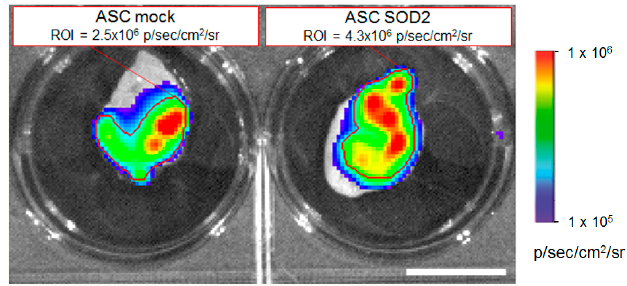
Figure 5. SOD2 -expressing ASCs show improved engraftment potential: ex vivo gel plug BLI analysis. Analysis of gel plugs excised at necropsy from one representative animal per group three days after implantation of Cultrex containing 7 × 10 5 luciferase-positive ASCs expressing either GFP (mock control) or SOD2 . Quantification of the BLI signals in the respective selected regions of interest (indicated by the red lines) confirmed improved engraftment of SOD2 -expressing cells compared to mock control. Scale bar: 1 cm.